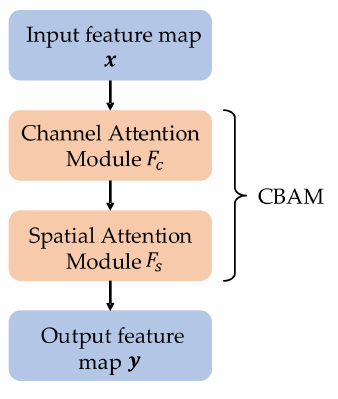
Figure 6. Structure of CBAM.